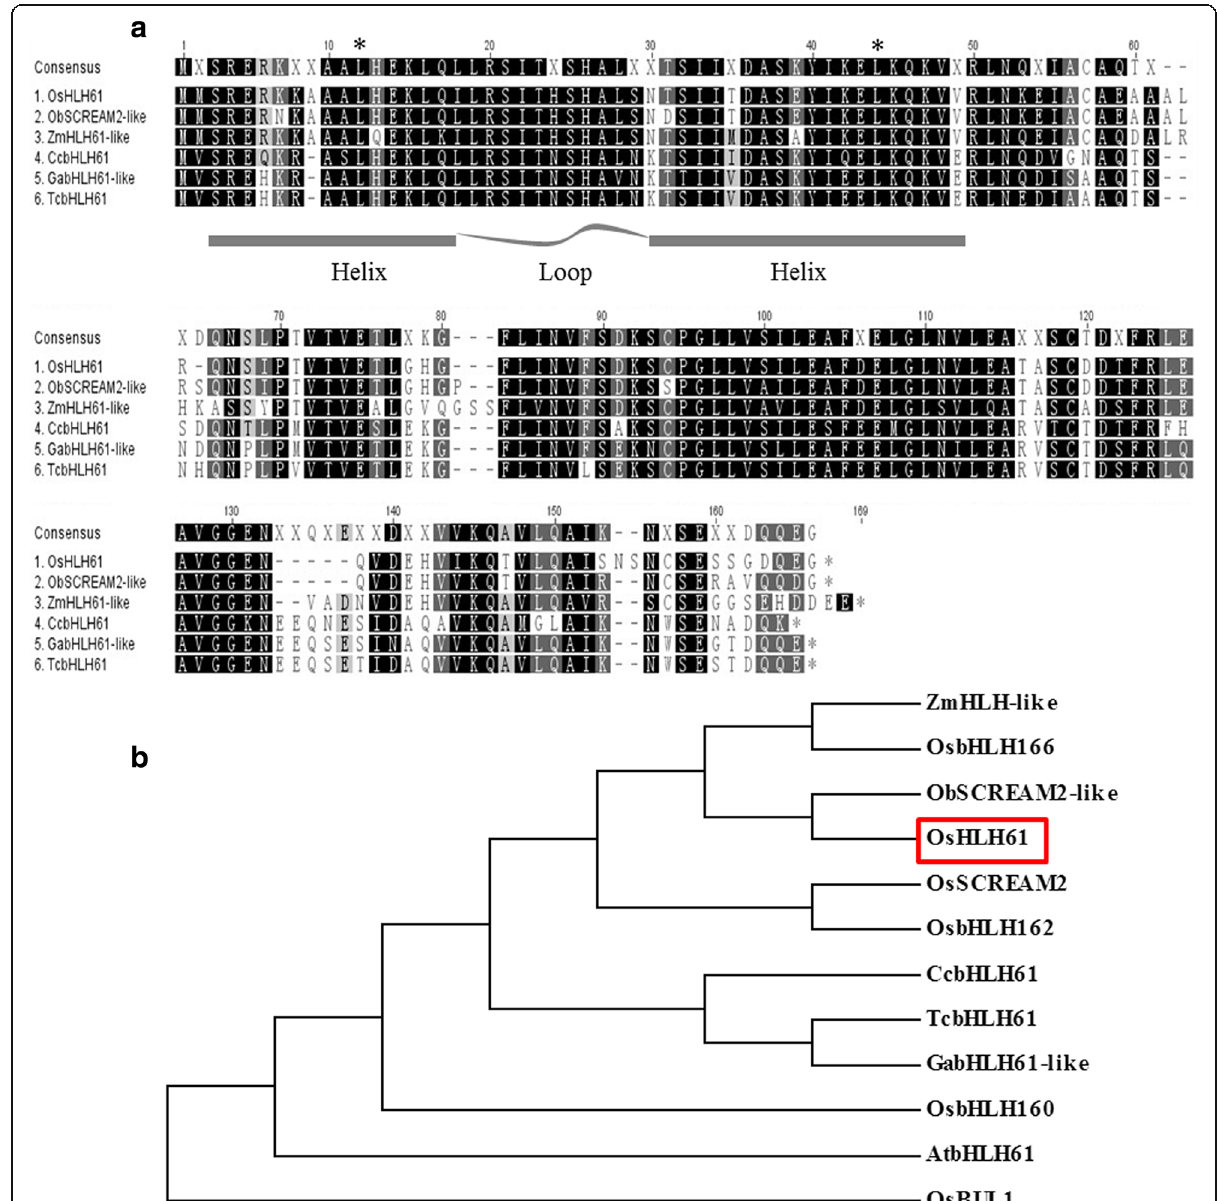
Fig. 1 Sequence alignment and phylogenetic tree of the homologues genes of OsHLH61 . a Sequence alignment of six HLH61 proteins from different species, the helix-loop-helix region was sketched, and asterisks indicated the conserved Leu12 and Leu44 positions. b Phylogenic tree of OsHLH61 and its homologues using the neighbor-joining method with 500 replications in Mega 6.0. OsHLH61 was indicated by red